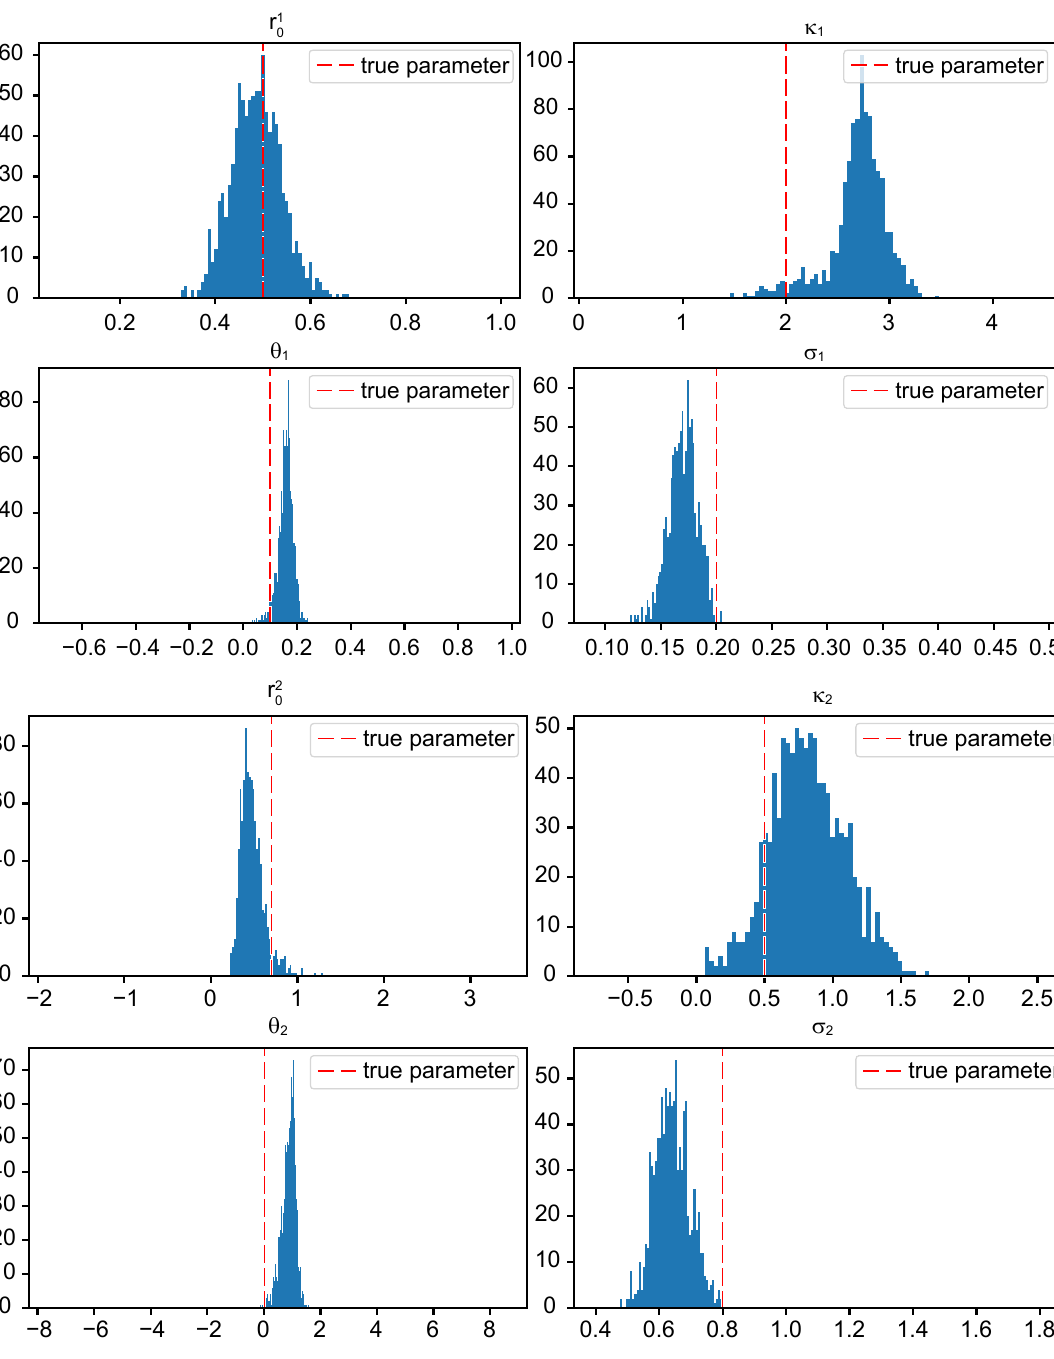
Figure 6. Histogram of the learned parameters obtained with the adaptive moment estimation (Adam) optimizer. The learning rate is 0.05 and training is performed over 750 epochs. Total simulations: 1000. We note that the range of learned parameters is narrower compared to the CG optimizer, resulting in a lower standard deviation (cf. Table